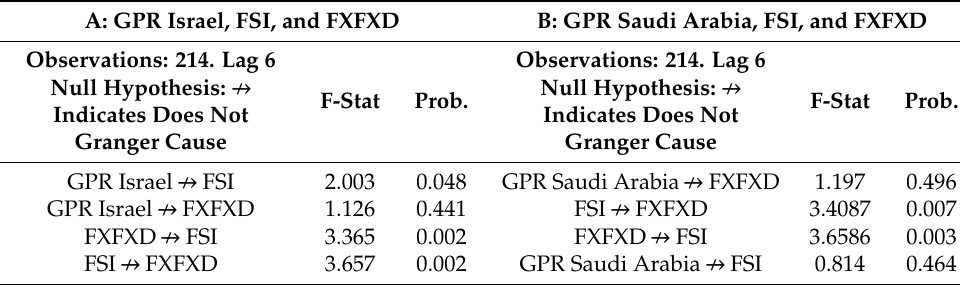
Table 13. Granger causality tests: GPR Israel, Saudi Arabia, FSI, and FXFXD. Table 14. Granger causality tests with one GPR. GPR Israel, Saudi Arabia, FSI, and FXFXD Number of Observations: 214 Lag 6 Null Hypothesis: ↛ Indicates Does Not Granger Cause F-Stat.